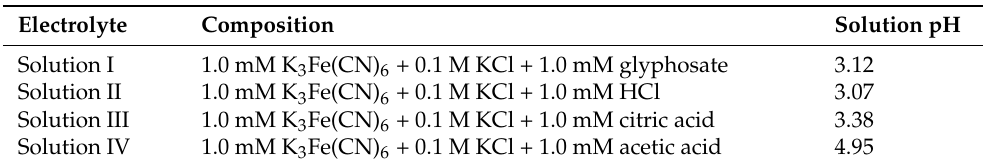
Table 1. The electrolytic solutions used for the electrochemical deposition of Prussian blue nanoparti- cles at SPCE/nano-Fe 3 O 4